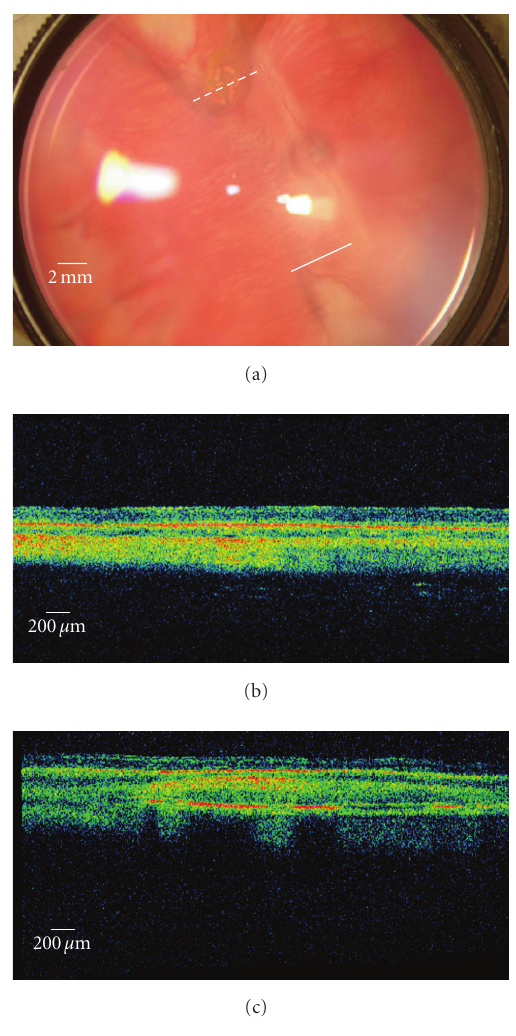
Figure 9: (a) A digital fundus photography of rabbit retina im- planted with a suprachoroidal electrode with two OCT (Stratus OCT 3000) scan paths (solid and dashed lines). A polyimide-based gold electrode had been implanted. Under gross inspection, the electrode is in its original position near the visual streak and no chorioretinal abnormalities can be found. (b) The OCT scan of the retina remote from the electrode (the solid line in the fundus pho- tography). The normal structures of the rabbit retina and choroid is demonstrated. (c) The OCT scan passing the electrode verti- cally (the dashed line in the fundus photography). The electrode is observed in the suprachoroidal space and in tight contact with the choroid. The metal plates in the electrode are highly reflective and leave posterior shadowing. The overlying retina showed nor- mal structures of